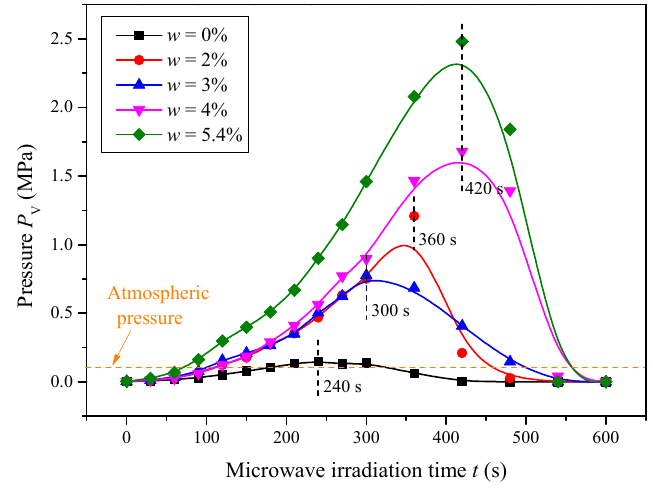
Figure 25. Variation of vapor pressures inside sandstone vs. microwave irradiation time.